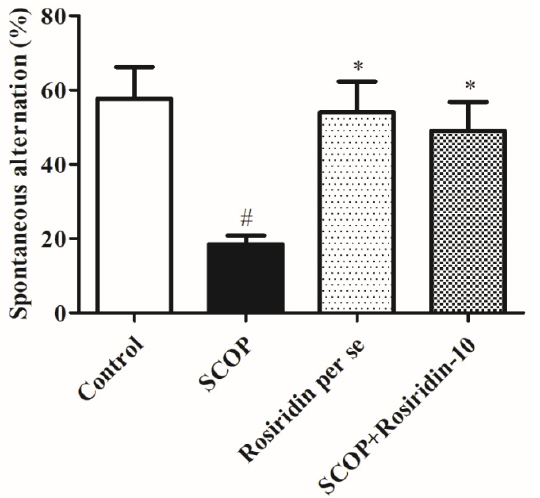
Figure 5. Graph depicts the effect of rosiridin in the Y-maze. Mean ± S.E.M. ( n = 6). # p < 0.001 vs. normal control, * p < 0.05 vs. scopolamine control; one-way ANOVA followed by Tukey’s